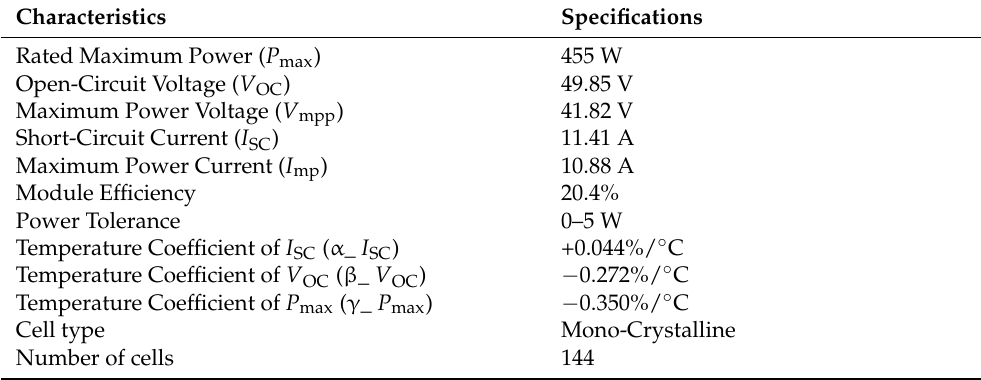
Table 2. Specifications of JAM72S20-455 PV module